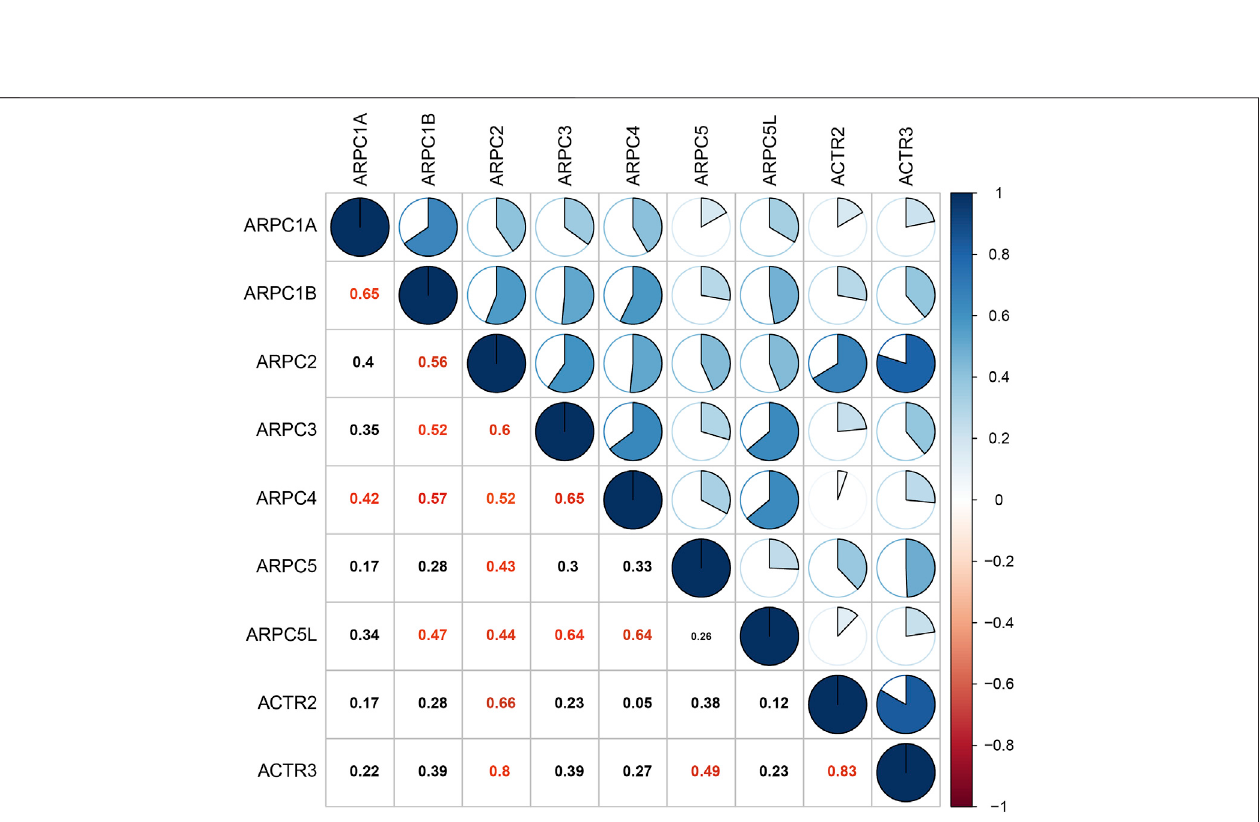
Frontiers in Molecular Biosciences |